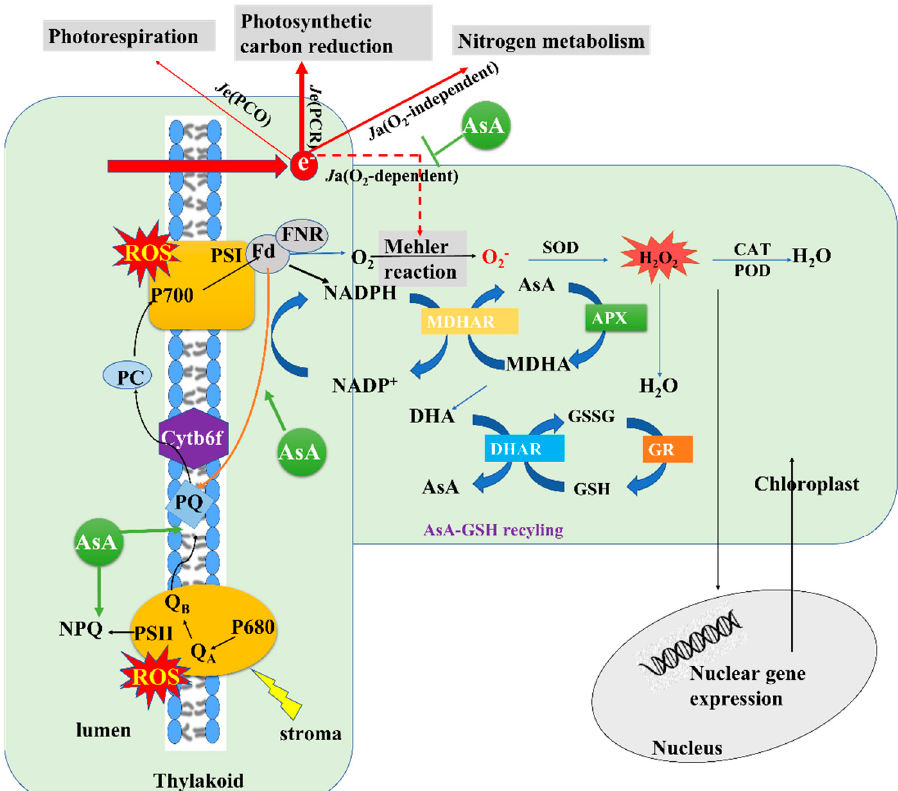
Figure 12. Schematic diagram of the effects of ascorbic acid (AsA) on photosynthetic electron transfer, current distribution, and reactive oxygen species (ROS) scavenging in the leaves of tomato seedlings under salt stress conditions. Note: the solid and dashed lines correspond to promotion and inhibition, respectively, while the relative thickness of arrows denotes an increase or decrease. Electrons generated by photosystem II (PSII) are transferred to photosystem I (PSI) via plastoquinone (PQ), the cytochrome b6/f (Cyt b6/f) complex, and plastocyanin (PC), and they ultimately reduce NADP + to NADPH via Fd (black arrow). In the context of cyclic electron flow (CEF) around PSI, Fd can transfer electrons back to PQ and then back to PSI via Cyt b6/f and PC (orange arrow). These electron transfer reactions are coupled with proton pumping into the thylakoid lumen and produce a proton gradient across the thylakoid membrane ( ∆ pH). AsA promotes an increase in CEF rate under salt stress and NaCl + lycorine treatment conditions, and this increase in CEF rate contributes to the formation of ∆ pH, which in turn induces an increase in non-photochemical quenching (NPQ), allocation of photosynthetic electron flux primarily to carbon assimilation and nitrogen metabolism, and a decrease in Mehler reaction electron flow. Increased NPQ induces increased photosynthetic electron flux, which is primarily allocated to carbon assimilation and nitrogen metabolism. This decreases Mehler reaction electron flow and increases the strength of the antioxidant system and the activity of key enzymes in the ascorbate–glutathione (AsA–GSH) cycle. This, in turn, reduces ROS levels, signals to the nucleus, increases gene expression, and provides negative feedback to the chloroplast, which ultimately alleviates oxidative damage to the electron donor and acceptor side of PSII. In addition, the increase in ∆ pH maintained the regulation of electron transfer by Cyt b6/f and avoided the excessive accumulation of electrons at PSI to reduce the oxidative damage on the acceptor side of